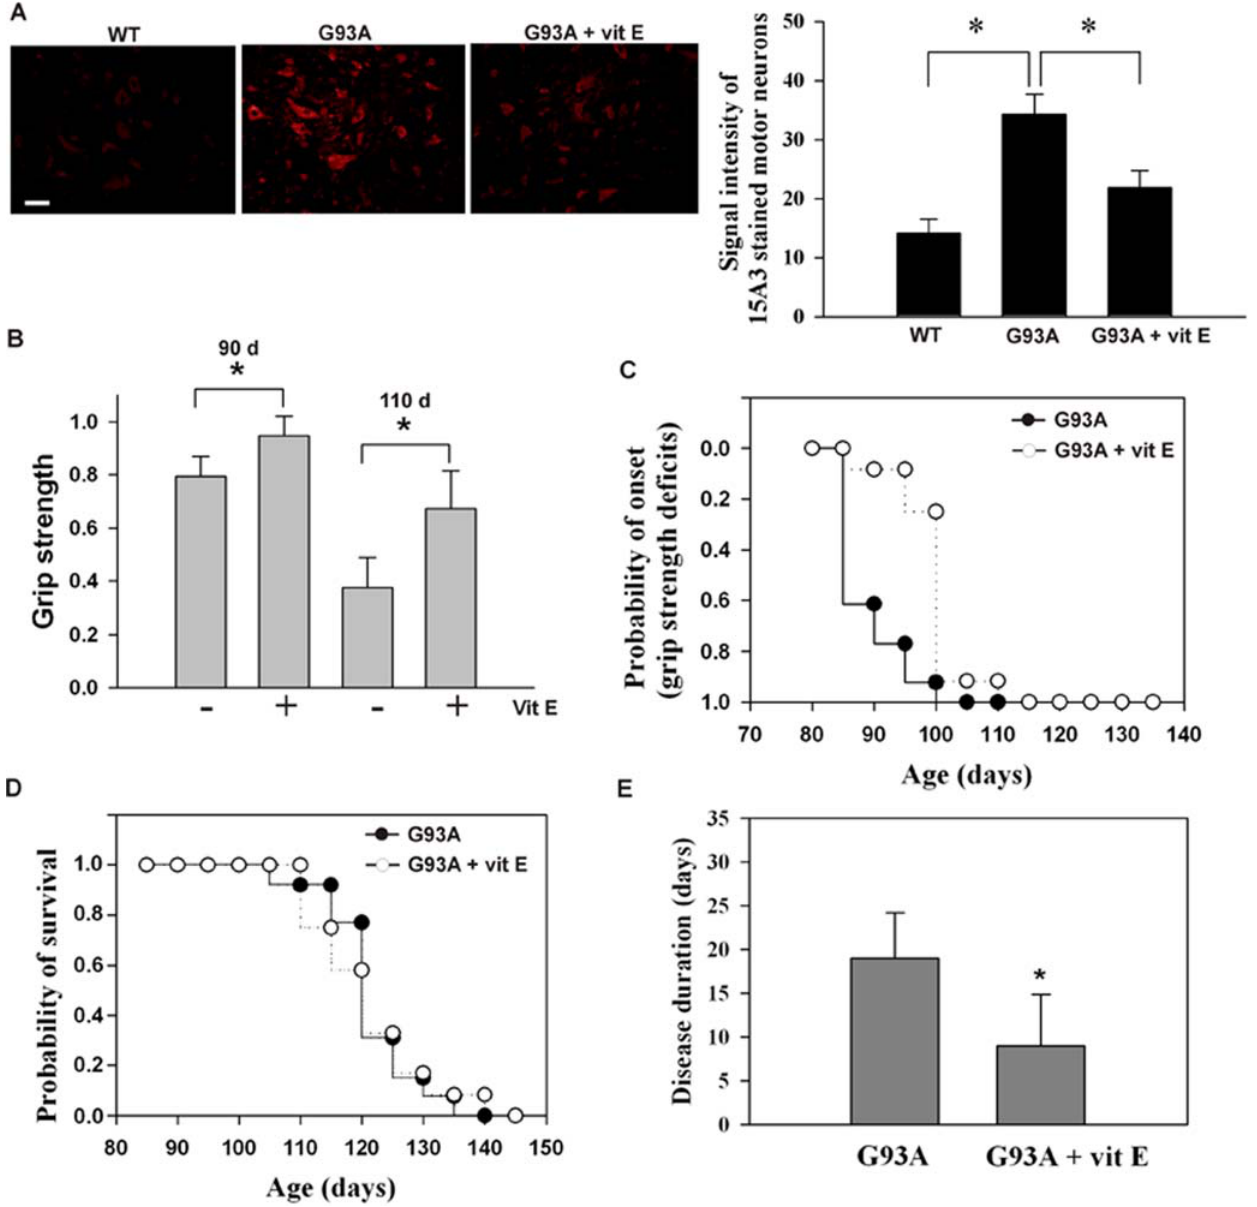
Figure 6. Vitamin E reduces RNA oxidation and delays the disease onset, but not the survival. ( A ) immunofluorescent staining of lumbar spinal cords sections prepared from indicated mice showed that RNA oxidation is significantly decreased in vitamin E treated mice (n=3 per group). Statistical analysis of immunoreactivity within motor neurons (n=20) is shown. * P , 0.01 ( B & C ) The decline in motor performance by measuring grip strength was significantly delayed ( , 14 days, * P , 0.005) in the vitamin E treated mice. There was no significant difference in the life span between the vitamin E treated and non-treated mice ( D ). The disease duration is significantly shortened (* P , 0.01) ( E ). n=17 each group.